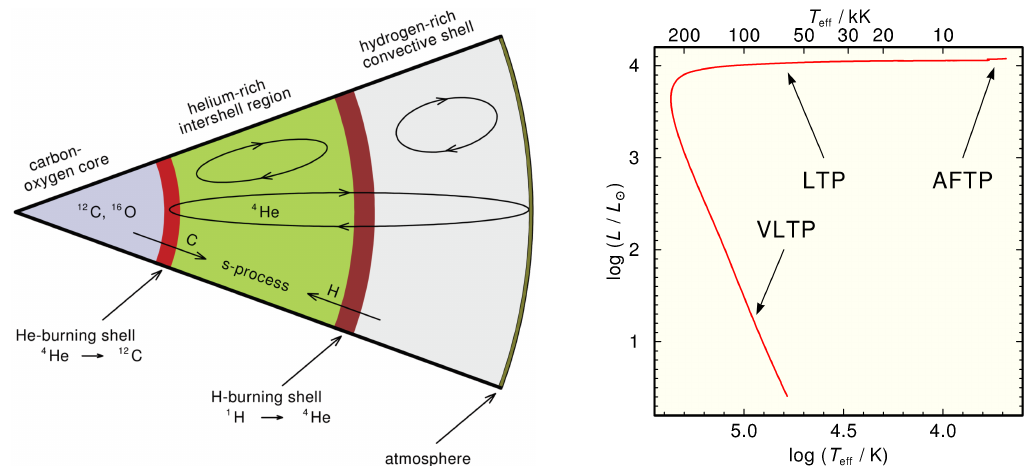
Figure 1. ( Left ): Internal structure of an AGB star (from [8]); ( Right ): Occurrence of AFTP, LTP, and VLTP in the Hertzsprung-Russell